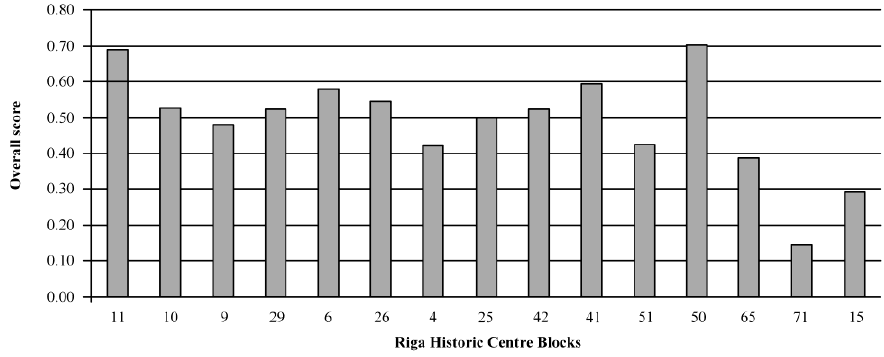
Fig. 6. Ranking the “Cultural heritage and liveability”